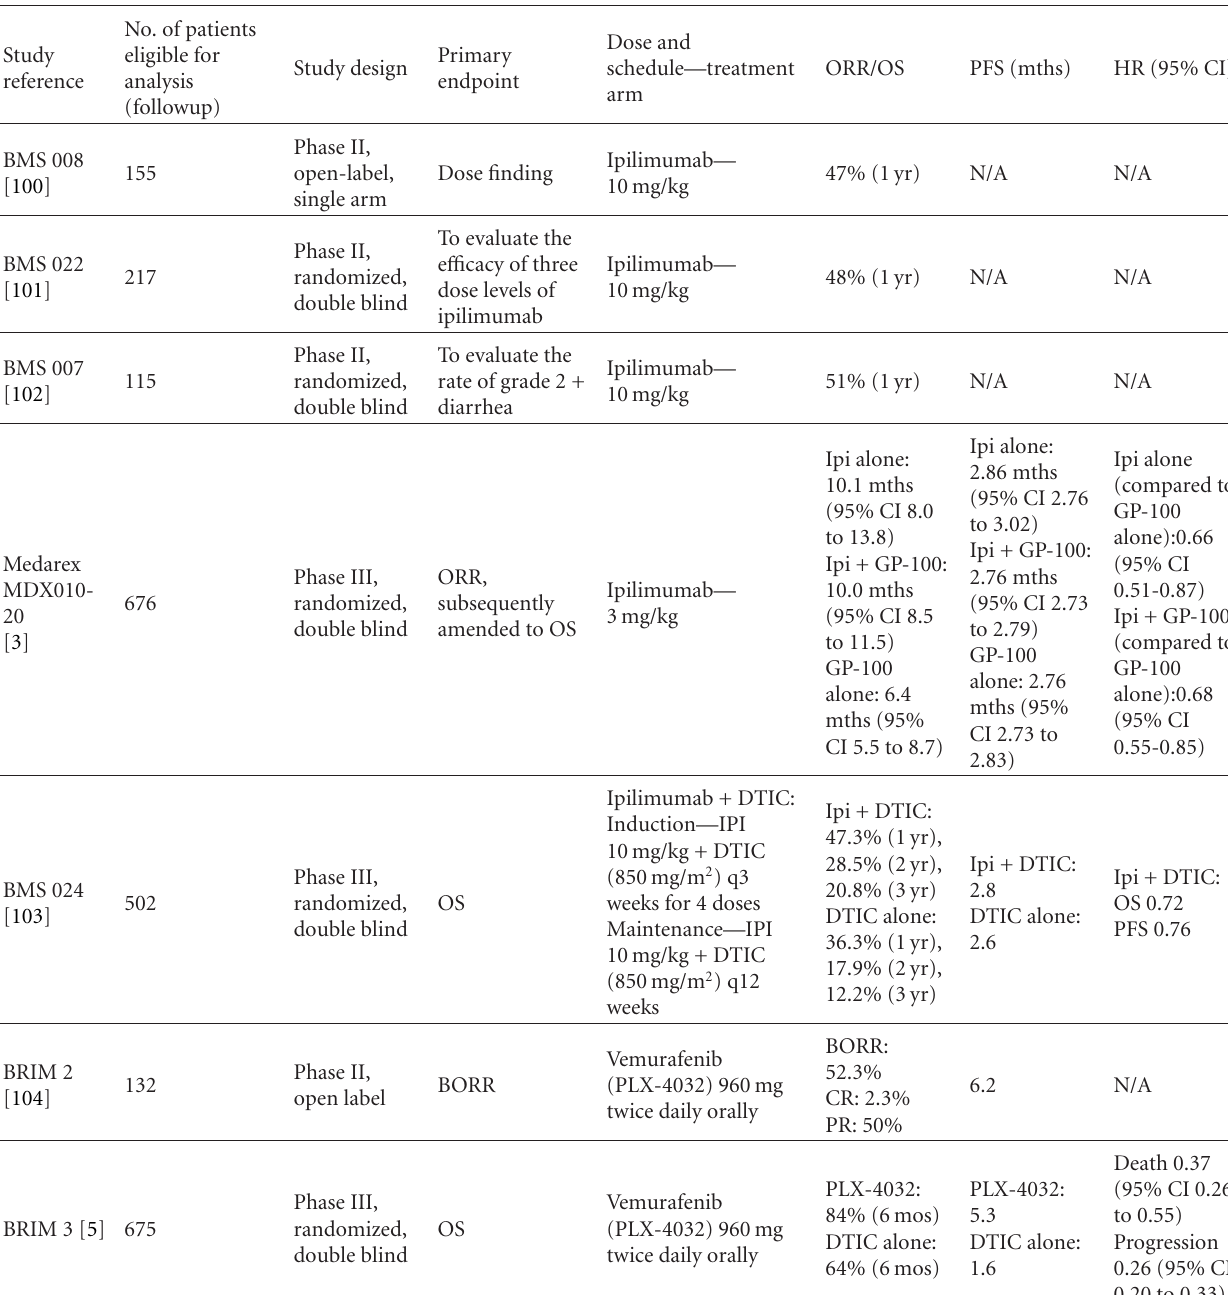
Table 4: Phase II/III studies of newer targeted